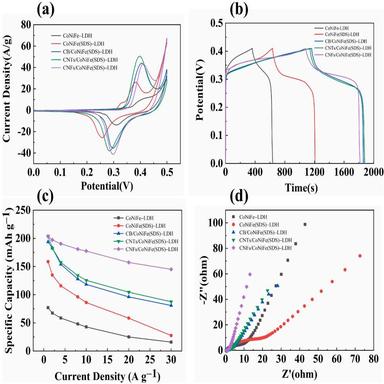
Electrochemical performance of CoNiFe–LDH, CoNiFe(SDS)–LDH, CB/CoNiFe(SDS)–LDH, CNTs/CoNiFe(SDS)–LDH and CNFs/CoNiFe(SDS)–LDH: (a) CV curves at 5 mV s − 1 ; (b) GCD curves at 1 A g− 1 ; (c) specific capacity at different current density and (d) Nyquist plots.